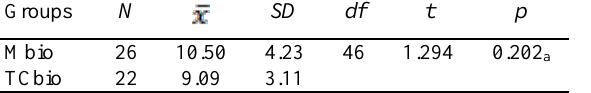
Table 1 T -test results of pre-BA scores of the students in Mbio and TCbio groups